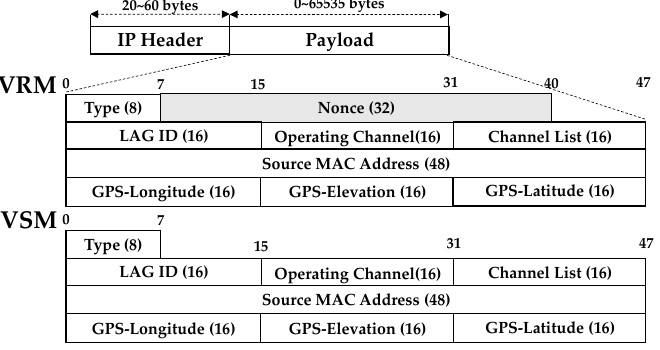
Figure 4. Messages of a vehicle node.